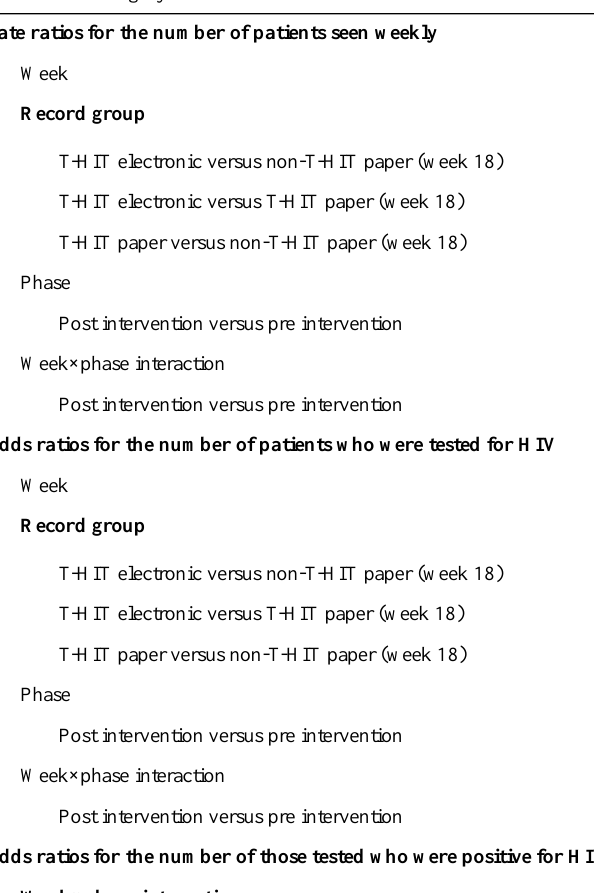
Table 3. Model outcomes for rate and odds ratios of patient visits, tested for HIV, and tested positive for HIV; Tanzania Health Information Technology (T-HIT) electronic records compared with paper records in T-HIT sites and comparison sites. Rate ratios for the number of patients seen weekly